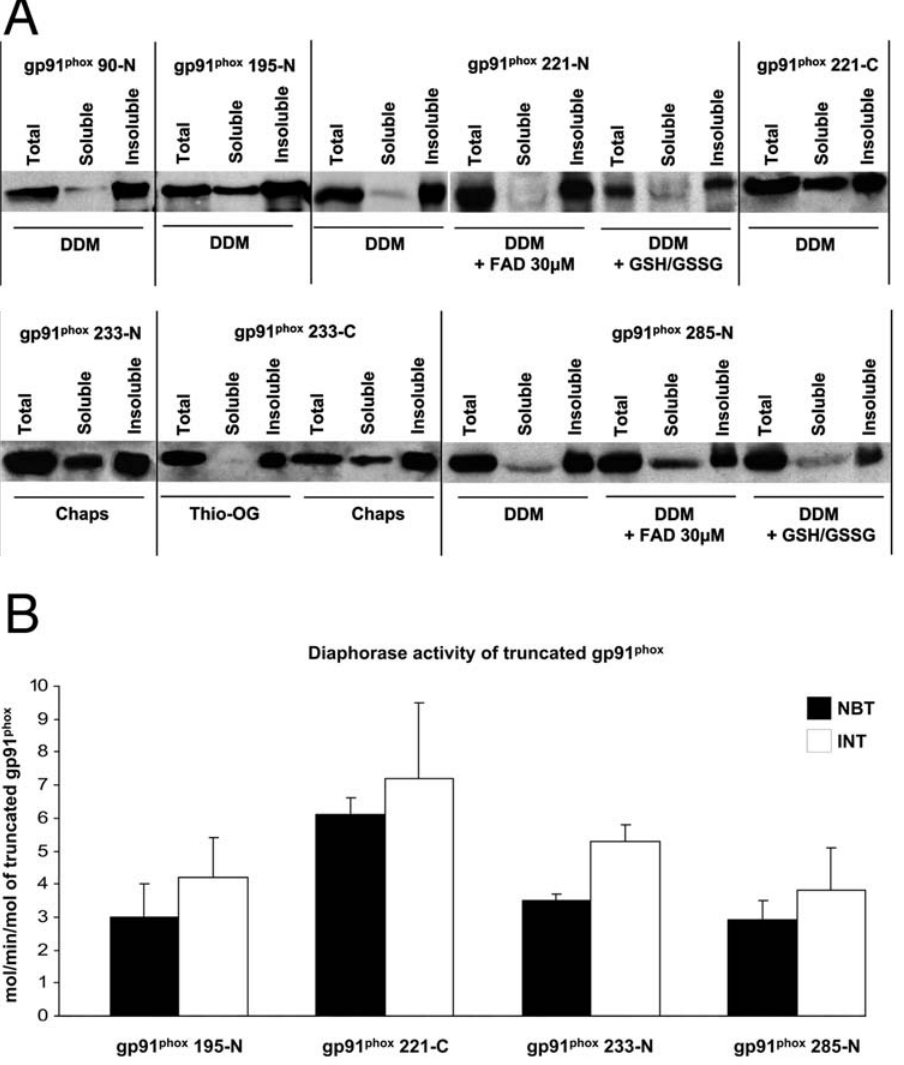
Figure 3. Solubility and activity of gp91 phox recombinant proteins. (A) Optimization of the solubility of the gp91 phox truncated proteins by western blot using a monoclonal antibody anti-his. (B) Diaphorase assay of purified soluble truncated gp91 phox proteins using NBT or INT as electron acceptor. Results were expressed as moles of NBT or INT reduced/min/mol gp91 phox truncated forms. Results are expressed as the average of at least two experiments 6